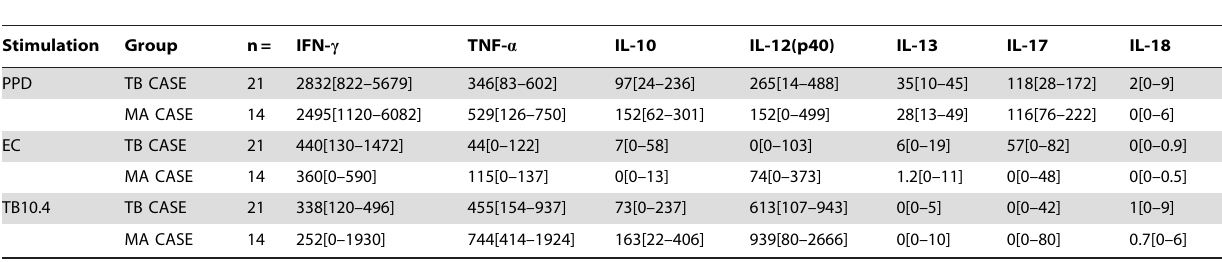
Table 3. Comparison of responses in M. Africanum versus M. Tuberculosis infected TB cases.